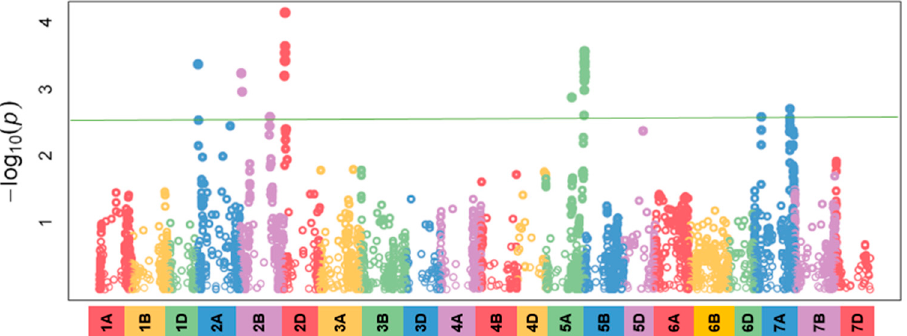
Figure 6. Manhattan plot, AUDPC BLUP values, across all experimental years and sites, according to the chromosomal localization of the markers (significance level: -log 10 ( p ) 2,5; Martonvásár 2006, 2007, 2009, 2011).